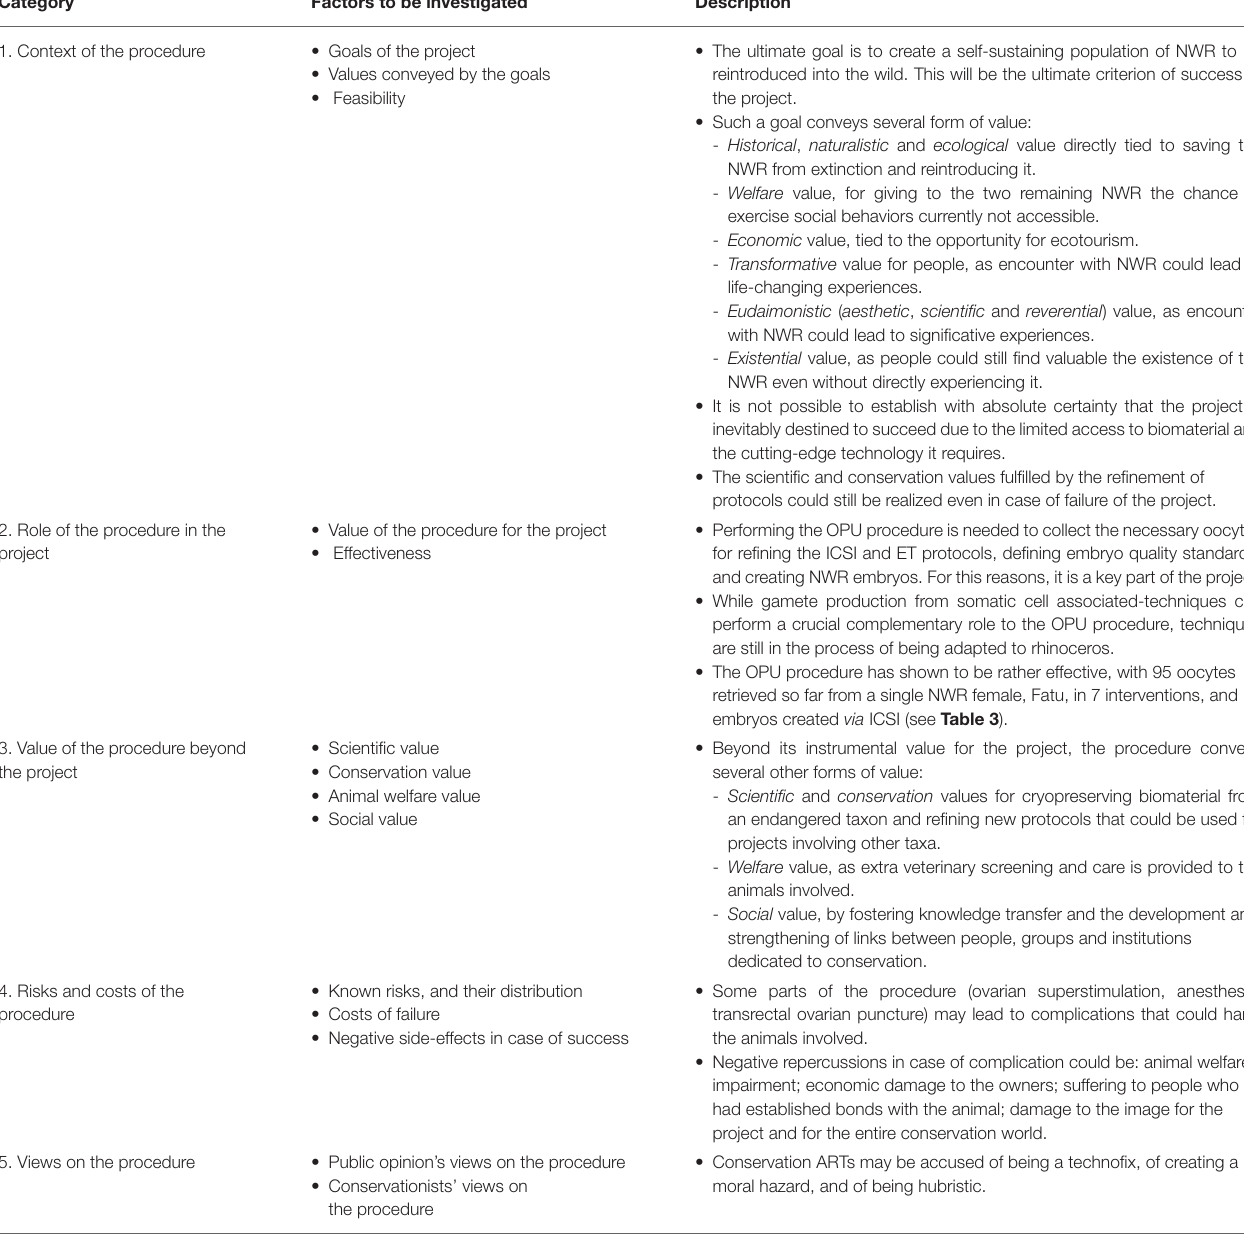
TABLE 5 | Factors for the ethical analysis of OPU procedures in white